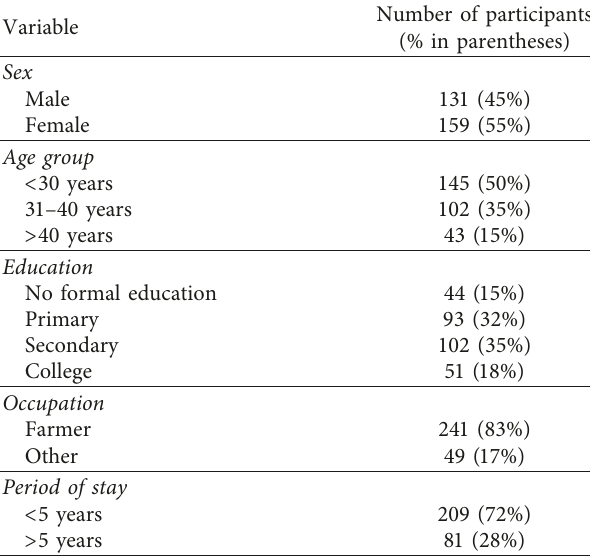
Table 1: Demographic characteristics of respondents from the Save Valley Conservancy survey from January to June